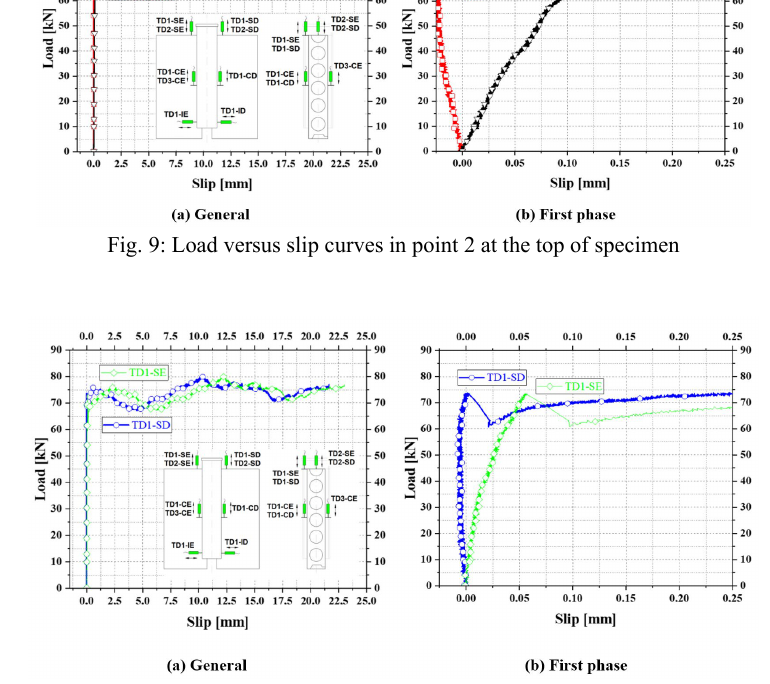
Fig. 10: Load versus slip curves in point 1 at the top of specimen